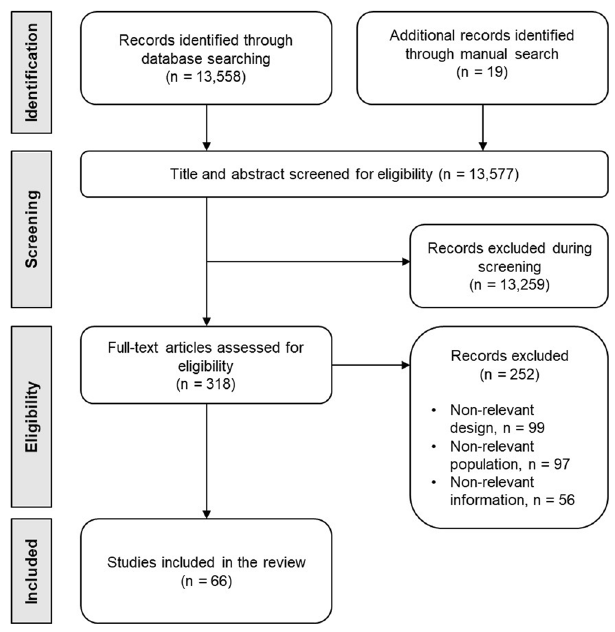
Fig. 1 Study selection fl ow-chart. Preferred reporting items for systematic reviews and meta-analyses (PRISMA) fl owchart outlining study selection